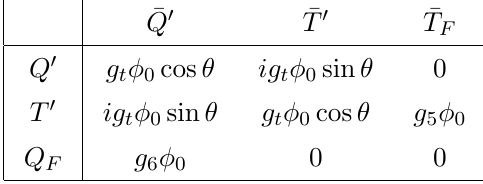
Table 6 . Charge-2 = 3 mass